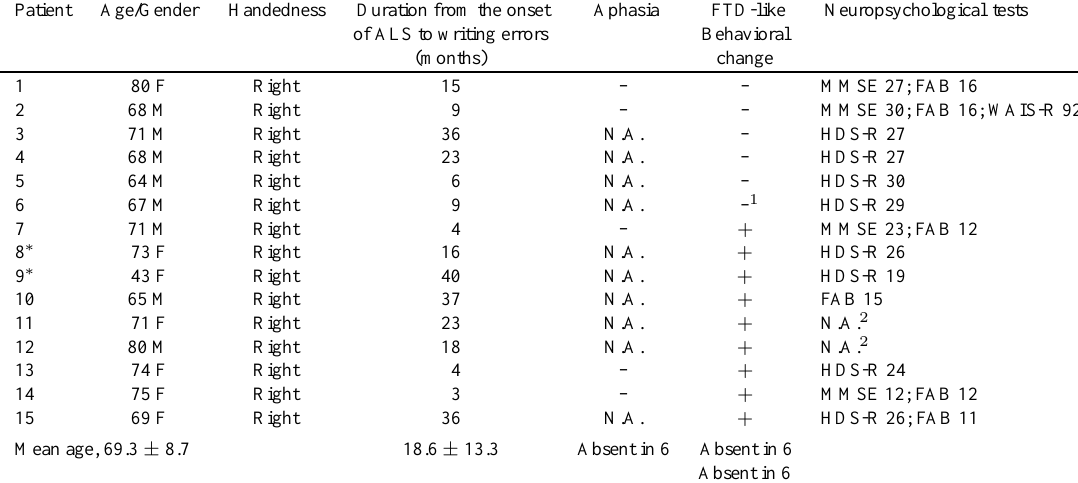
Table 1 Summary of background of 15 patients with writing errors